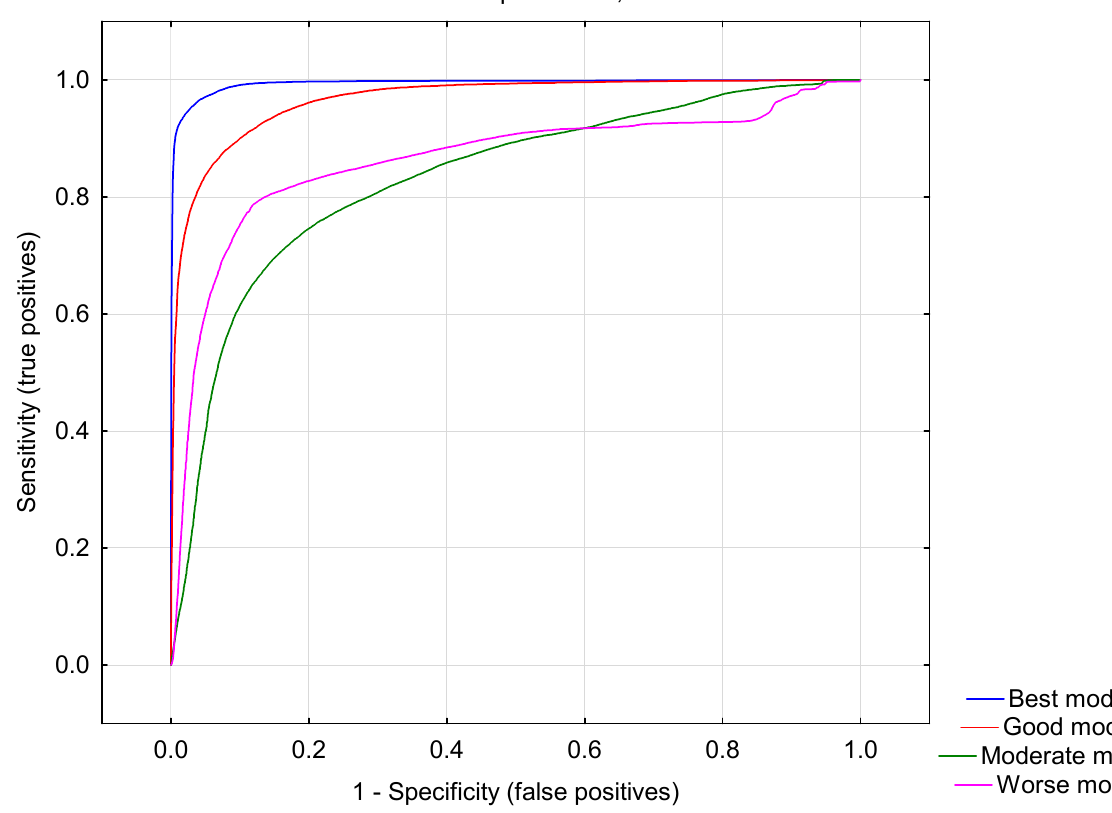
Figure 1. ROC curve for best, good, moderate and worse models found.